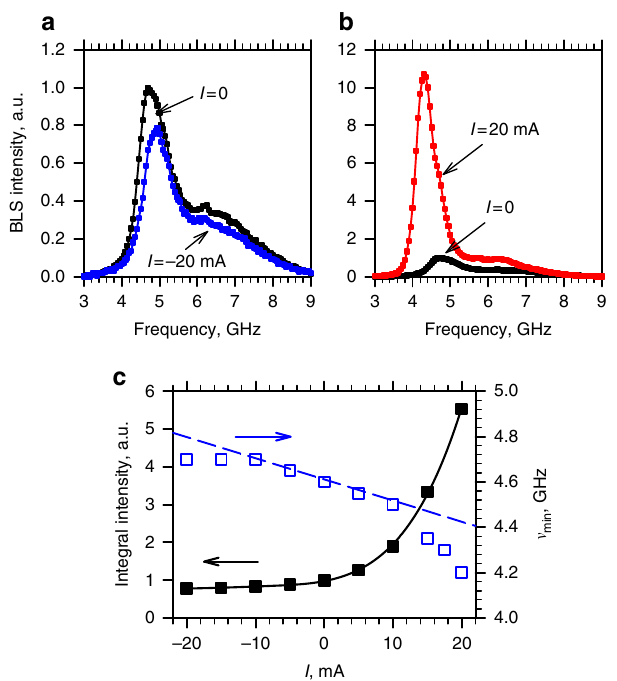
Fig. 2 Effects of spin current. a , b Representative BLS spectra recorded at I = − 20 and 20 mA, respectively, together with the reference spectrum obtained at I = 0. c Current dependences of the BLS intensity integrated over the measured spectrum (solid squares) and of the frequency of the lowest-energy magnon state ν min (open squares). Solid curve is a guide for the eye. Dashed line shows the calculated variation of ν min due to the Oersted fi eld of the current. The data were obtained at H 0 = 200